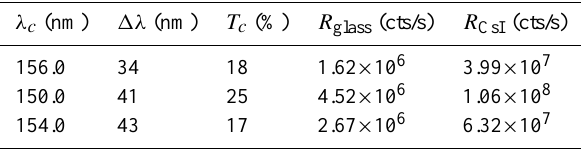
Table 2. Columns 1–3: transmission properties for filters appropri- ate to the WFAI instrument, based on those flown on the DE-1 mis- sion. Columns are central wavelength, bandpass FWHM, and trans- mission at central wavelength. Columns 4 & 5: estimated count rate for dayside auroral observations in each band, for a bare glass and CsI photocathode-equipped detector respectively, for a single WFAI module with 45.8 ◦ × 45.8 ◦ field of